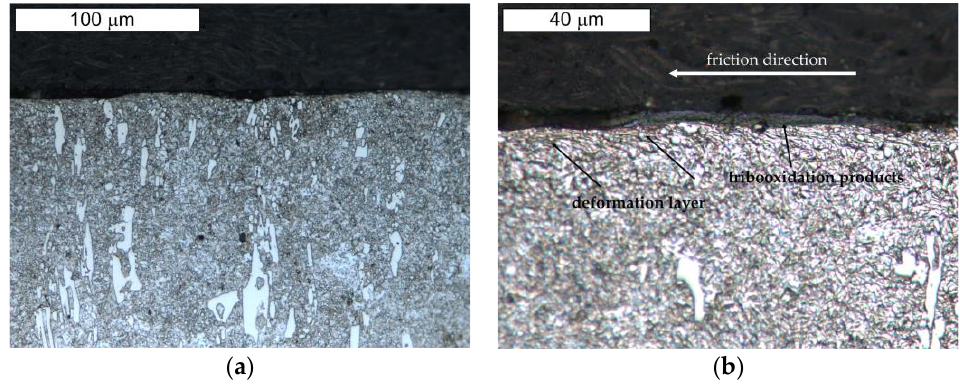
Figure 18. View of ( a ) the microstructure of steel NC11 in the surface area and ( b ) a magnified frag- ment of the area from Figure 18a. Light microscopy, etched.